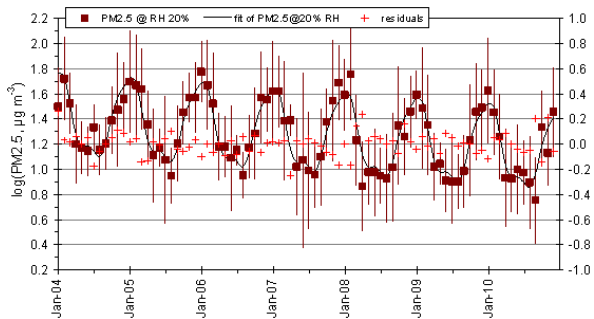
Figure 2. Variations in the aerosol scattering coefficient at 550nm at IPR: logarithm of the monthly mean values at instrumental RH (open circles), at 0% RH (squares), least mean square fit of the log- arithm of the monthly mean values at 0% RH (line), and residuals (crosses, right axis). Error bars show the standard deviation of the log of the monthly mean values at 0%